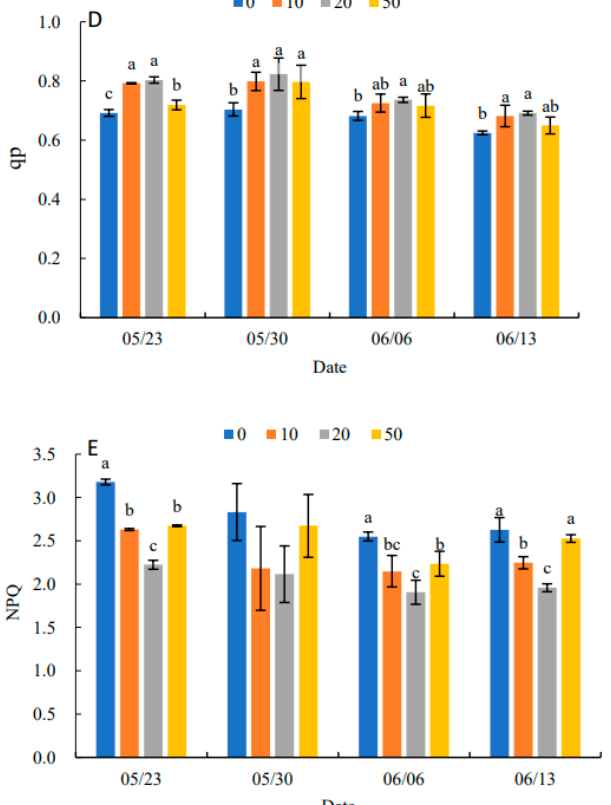
Figure 5. Effects of different concentrations of 5-ALA on the maximal efficiency of PSII photochem- istry (Fv/Fm) ( A ), the effective efficiency of PSII photochemistry (Fv ′ /Fm ′ ) ( B ), actual PSII efficiency ( Φ PSII ) ( C ), photochemical quenching (qP) ( D ) and non-photochemical (NPQ) ( E ) in P. heterophylla from 23 May to 13 June. Different letters indicate a significant difference at 0.05 level between different treatments.